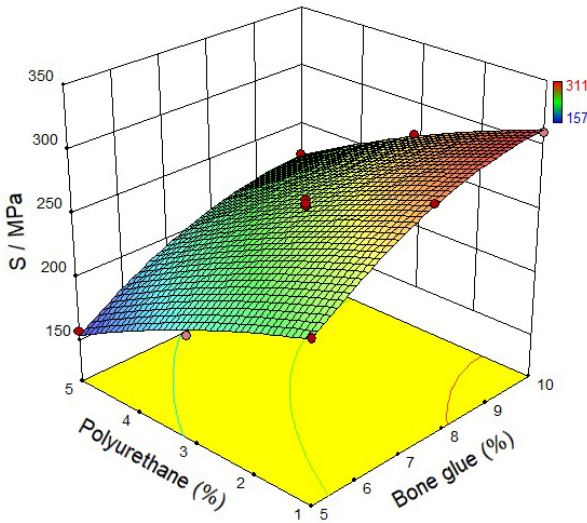
Figure 7. Stiffness modulus of CMA.